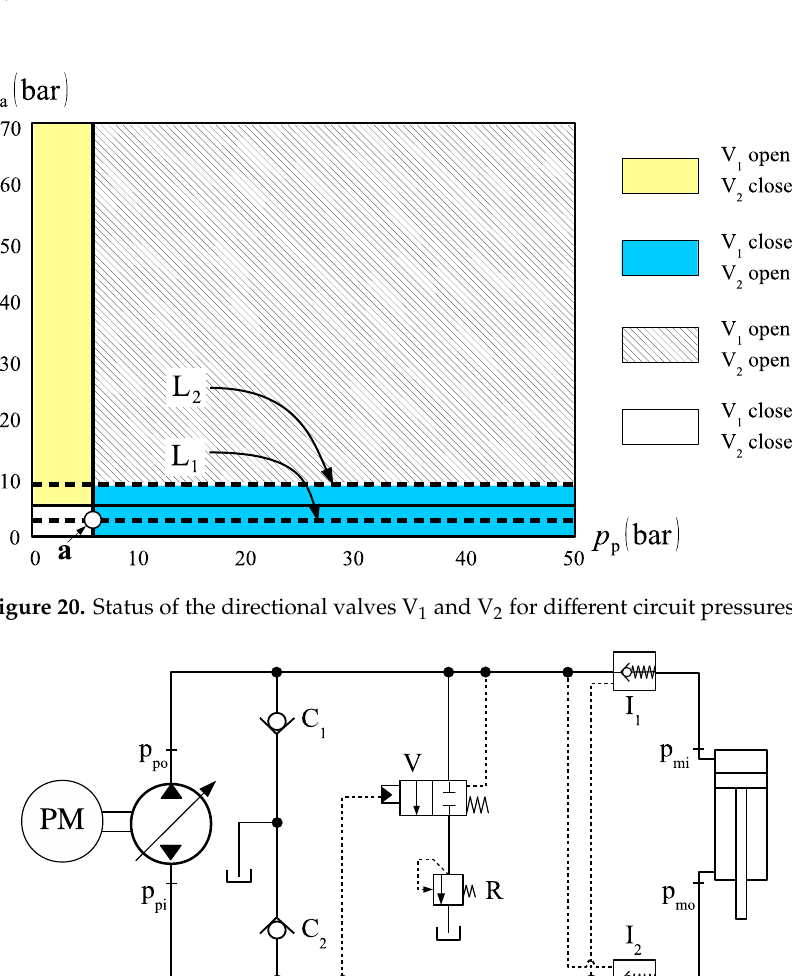
Figure 21. Circuit with 2 × 2 compensation valve and inline check-valves.